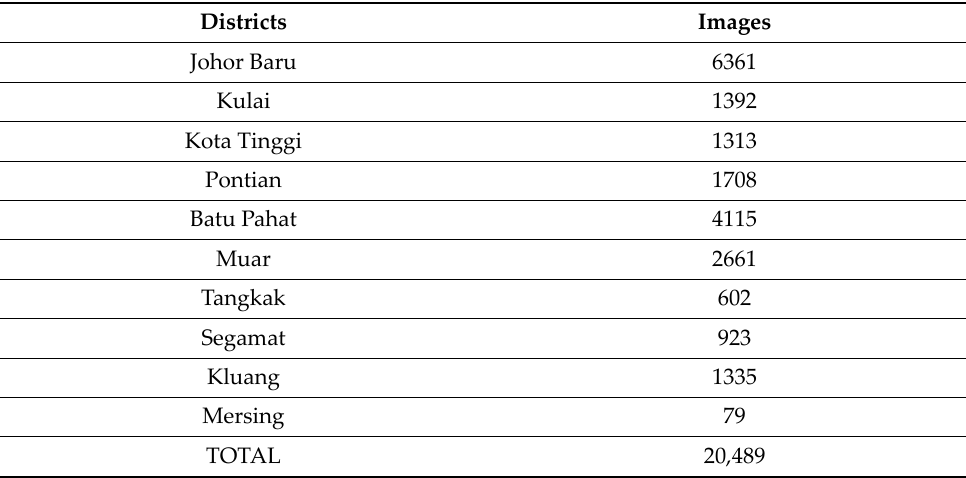
Table 2. Total Photographs Taken in Each District.